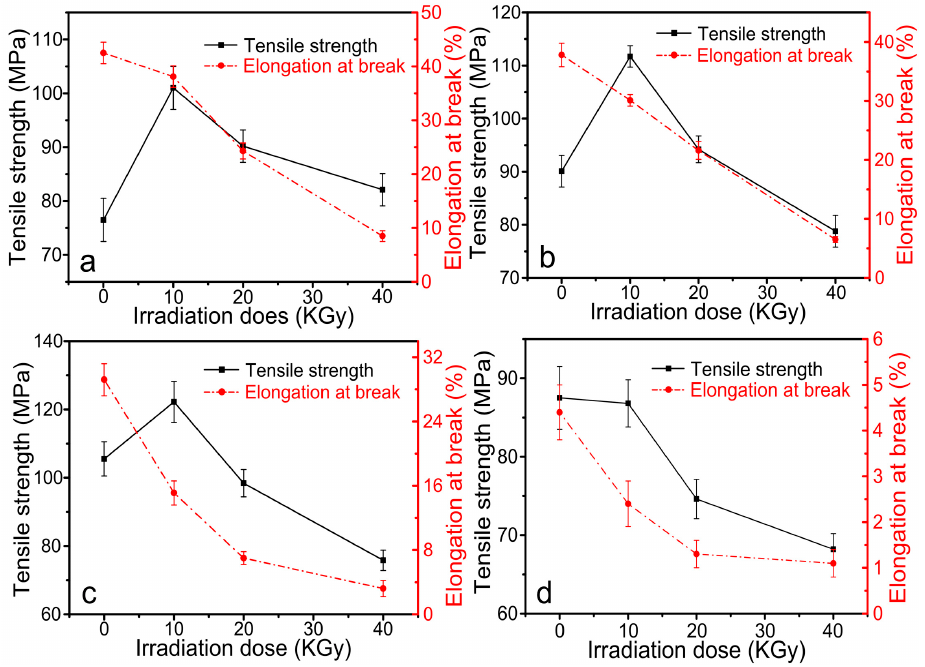
Figure 7. Tensile strength and elongation at break of CS/GO composite films with different content of GO: ( a ) 0 wt %; ( b ) 1 wt %; ( c ) 3 wt %; ( d ) 5 wt % under the various irradiation doses.